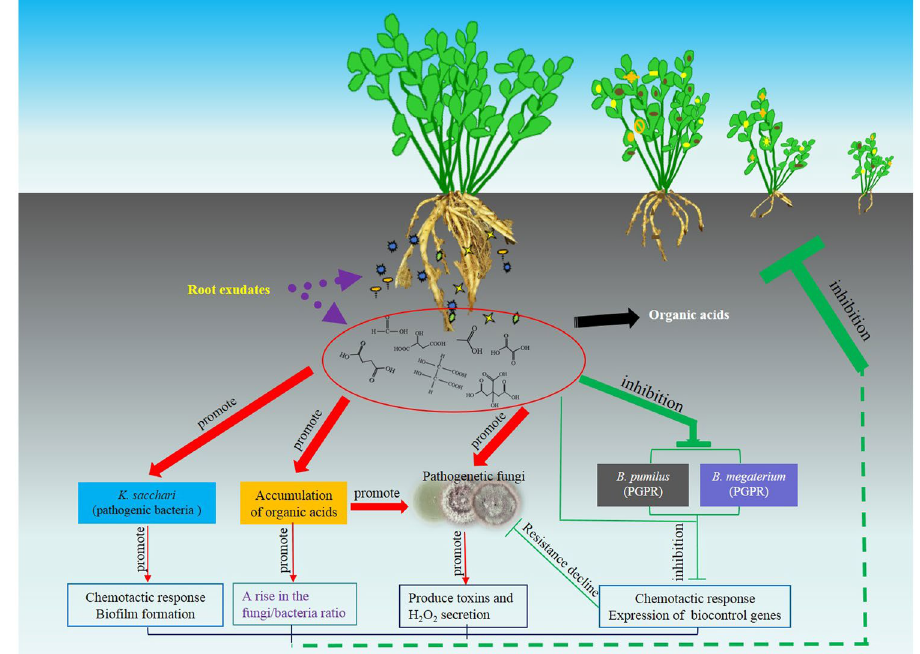
Figure 10. Tentative graphic of the communication between root exudates and